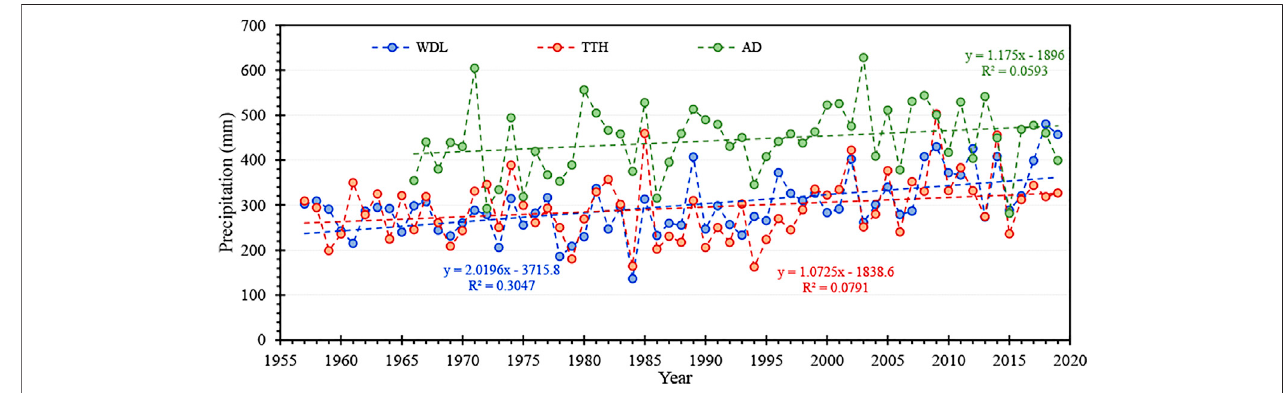
FIGURE 3 | Long-term records in annual total precipitation at WDL and TTH (1957 – 2019) and AD (1966 – 2019) weather